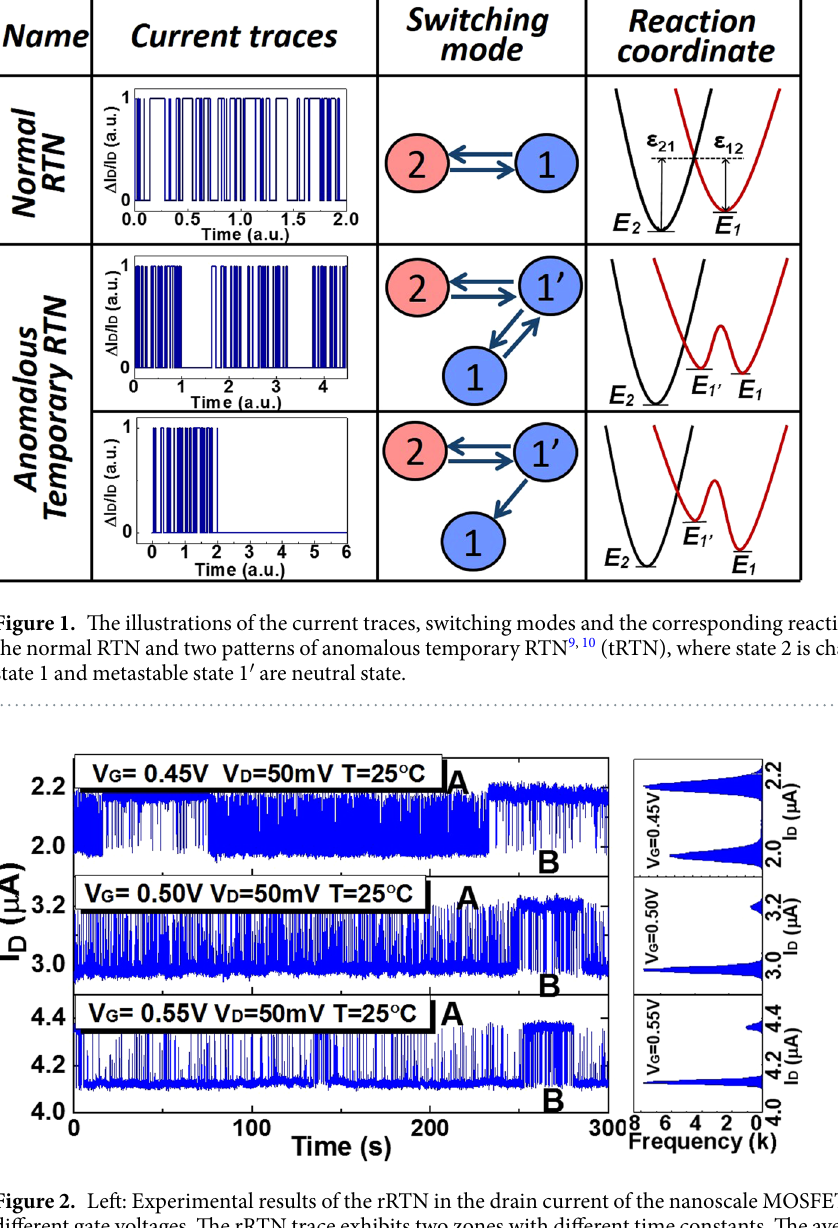
Figure 2. Left: Experimental results of the rRTN in the drain current of the nanoscale MOSFET under three different gate voltages. The rRTN trace exhibits two zones with different time constants. The average transition time between zone A and zone B is hundreds of seconds. Right: The histograms of the RTN data at different V G , indicating the two current